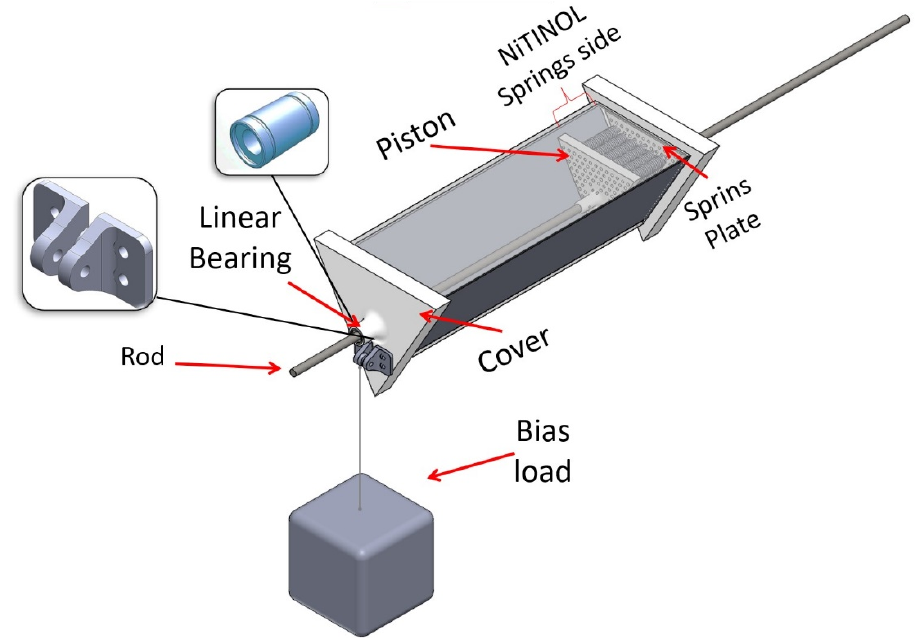
Figure 3. Detailed CAD model of the solar-driven thermomechanical SMA actuator.